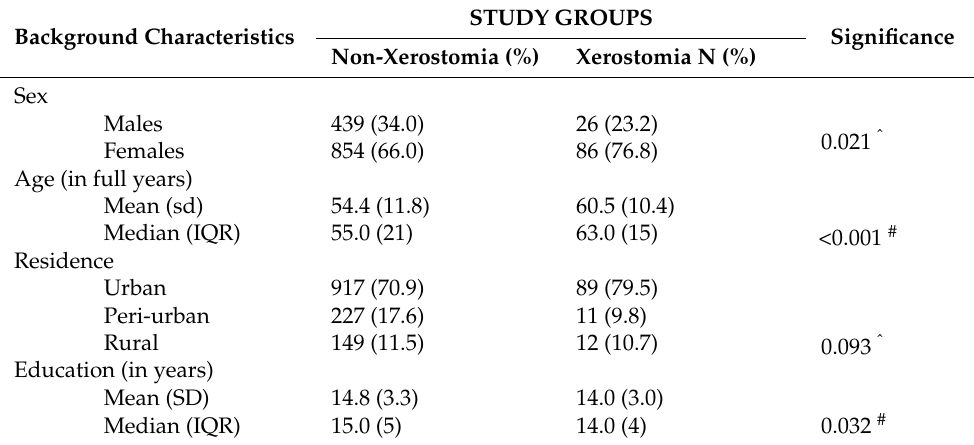
Table 2. Comparison of participants’ background characteristics between the participants stratified by the absence/presence of xerostomia.